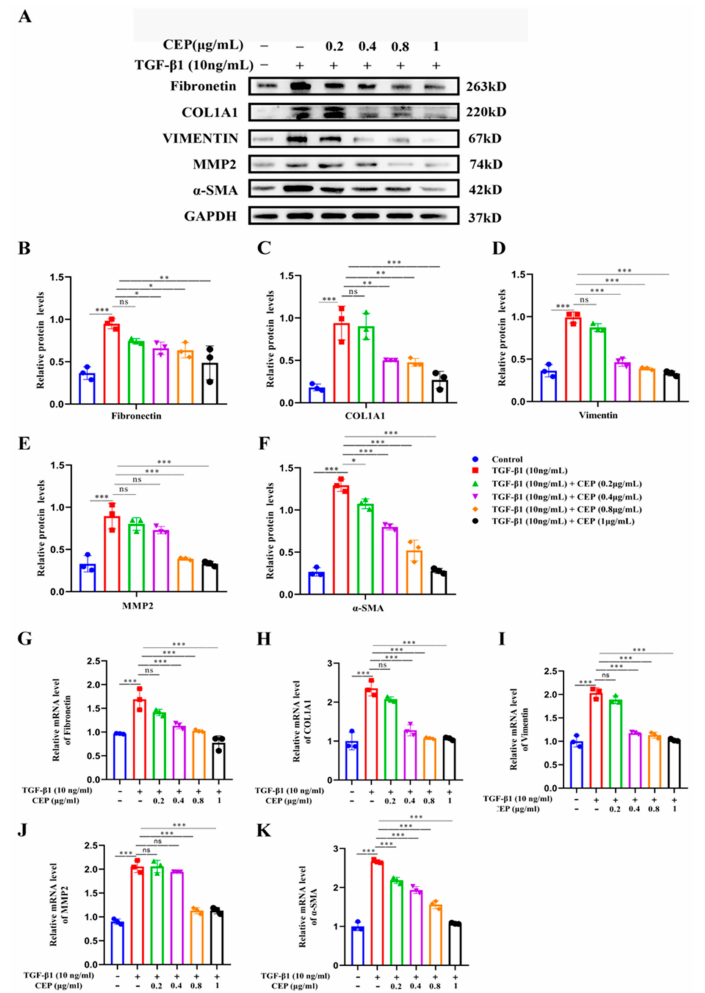
Figure 3. Mechanism of CEP for regulating FMT in TGF- β 1-induced PF in vitro. ( A ): Protein levels of Fibronectin, COL1A1, Vimentin, MMP-2, and α -SMA measured with Western blotting, respec- tively. ( B ): Fibronectin protein level was quantified by grayscale value and Image J software was used. ( C ): COL1A1 protein level was quantified by grayscale value and Image J software was used. ( D ): Vimentin protein level was quantified by grayscale value and Image J software was used. ( E ): MMP-2 protein level was quantified by grayscale value and Image J software was used. ( F ): α -SMA protein level was quantified by grayscale value and Image J software was used. ( G ): The mRNA levels of fibronectin measured with RT-qPCR. ( H ): The mRNA levels of COL1A1 measured with RT-qPCR. ( I ): The mRNA levels of vimentin measured with RT-qPCR. ( J ): The mRNA levels of MMP-2 measured with RT-qPCR. ( K ): The mRNA levels of α -SMA measured with RT-qPCR. ns: no statistical difference, * p < 0.05, ** p < 0.01, and *** p <